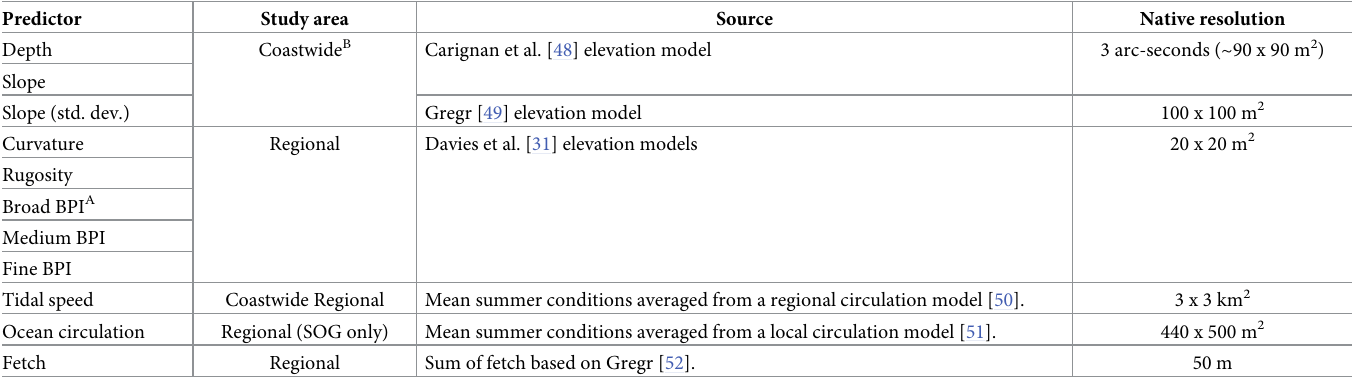
Sum of fetch based on Gregr